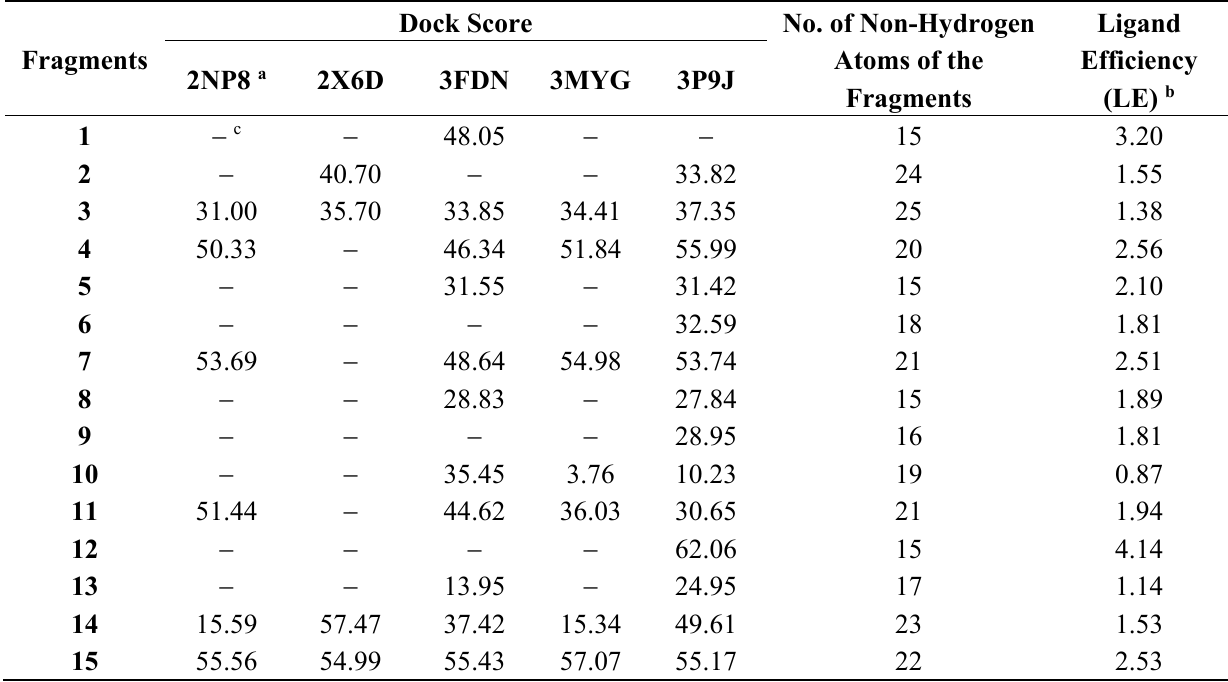
Table 1. The dockscores and ligand efficiency for the selected 15 fragments. Fragments